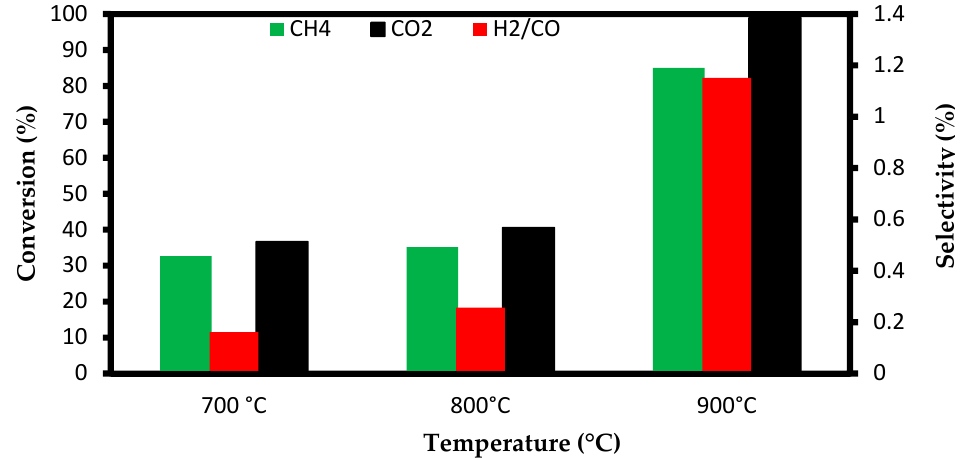
Figure 10. The influence of temperature on the catalytic activity of the Pd,Pd,Ni/Mg 0.85 La 3+0.15 O catalyst: (1) 700 °C, (2) 800 °C, (3) 900 °C for the 1:1 ratio of CH 4 :CO 2.